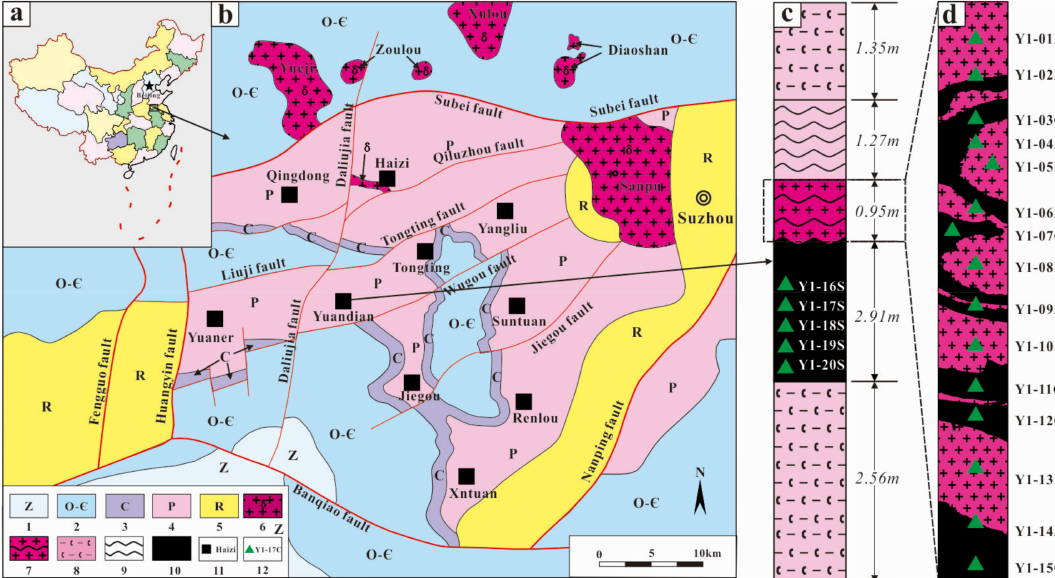
Figure 1. Location of the Yuandian Coal Mine in the Huaibei Coalfield, Anhui, China. Map of China, showing the location of the Huaibei Coalfield ( a ), regional geological map of the Yuandian Coal Mine ( b ), stratigraphy of coal seam VIII ( c ) and sampling locations (green triangle) ( d ). (1) Sinian, (2) Cambrian–Ordovician, (3) Devonian, (4) Permian, (5) Tertiary, (6) diabase, (7) intrusion-related cokeite, (8) shale, (9) schist, (10) coal seam, (11) coal mine, (12) sampling location and